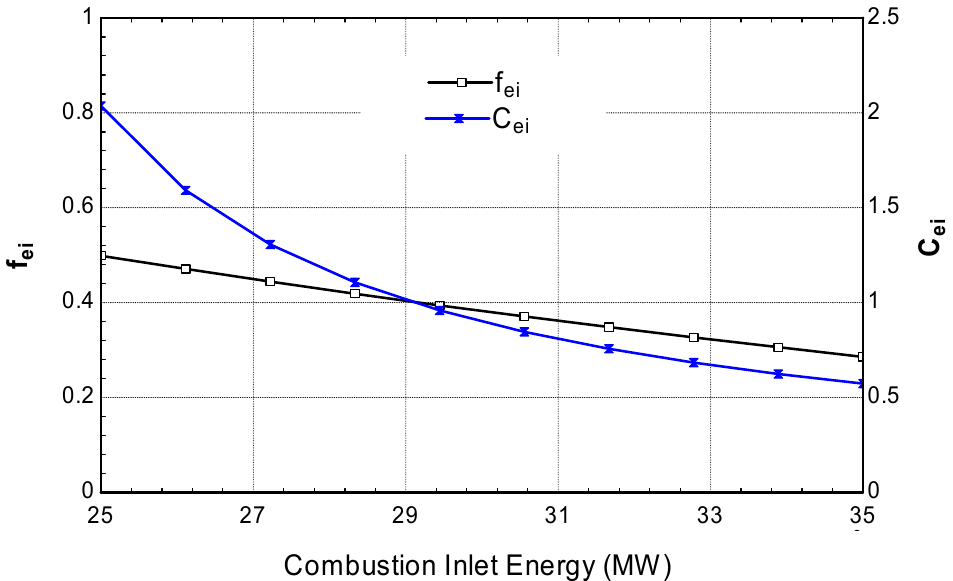
Figure 7. Impact of varying the combustion inlet energy rate on the exergoenvironmental impact factor and exergoenvironmental impact index of the overall system.